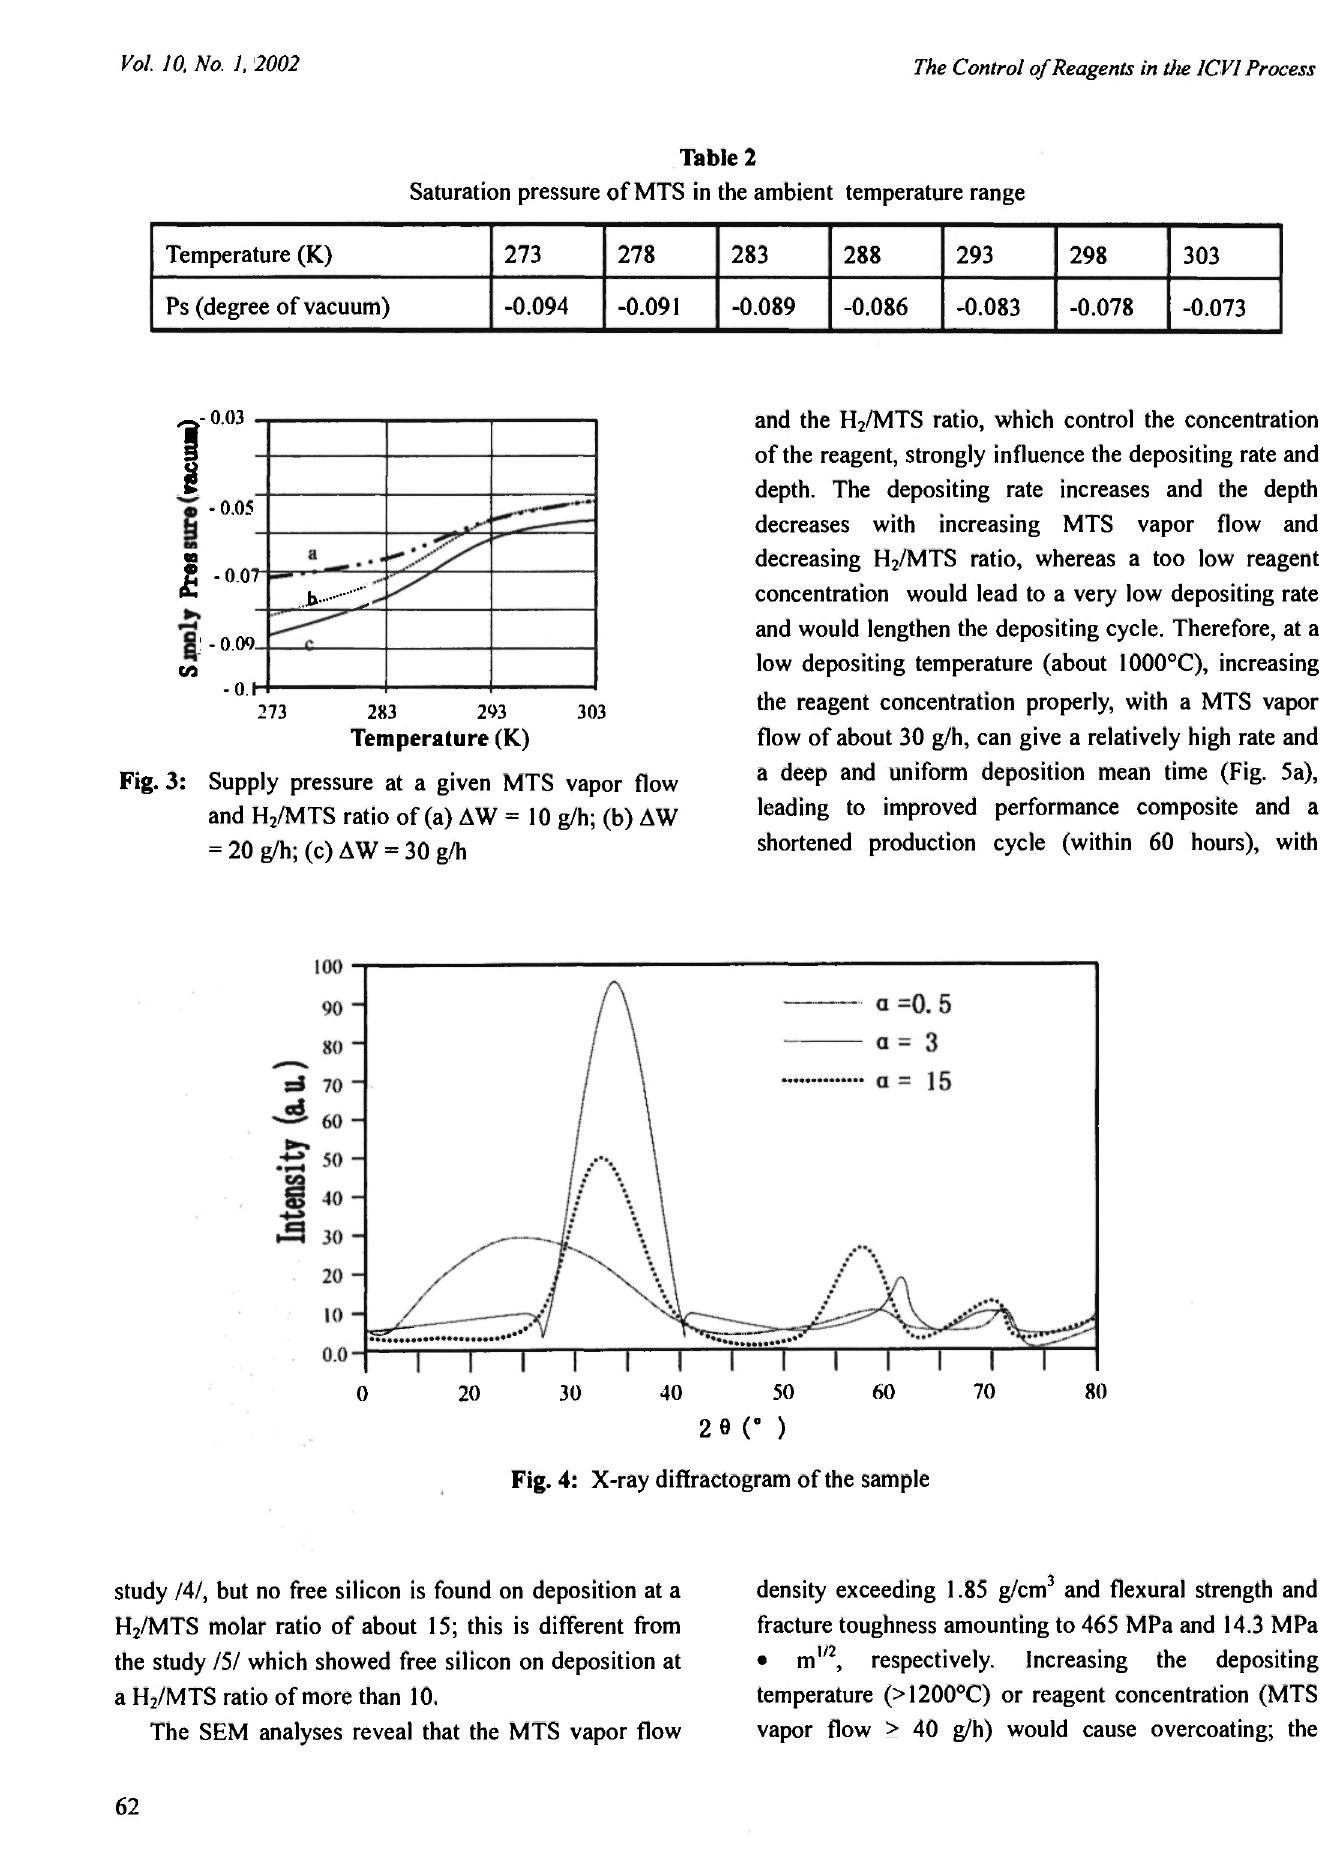
Saturation pressure of MTS in the ambient temperature range